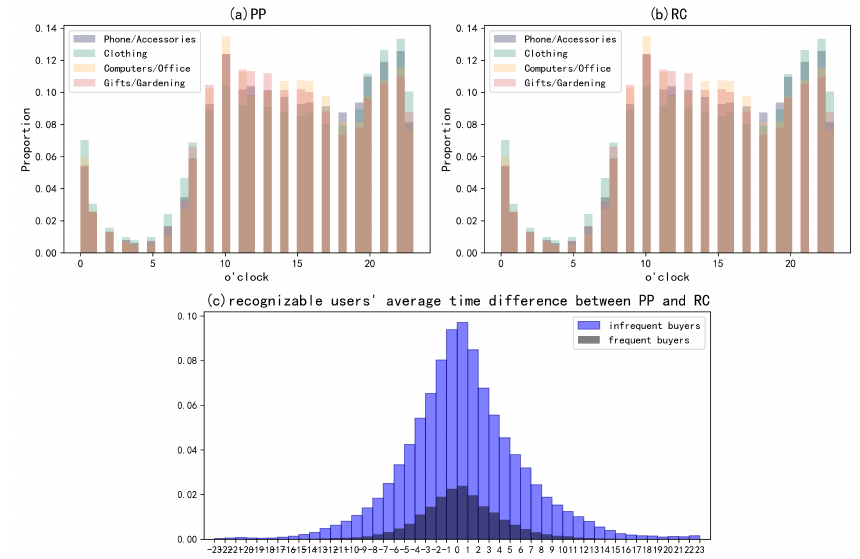
Figure 5. Distributions of PP or RC times and their intervals derived from uniquely identified consumers on a 2 h scale. ( a ) PP distributions for four different product categories on an hourly scale. ( b ) RC distributions for four different product categories on an hourly scale. ( c ) Distribution for identified consumers’ average intervals between PP and RC times for all four product categories on an hourly scale. Here, we filter out identified consumers in every sector who have no less than three purchases in our